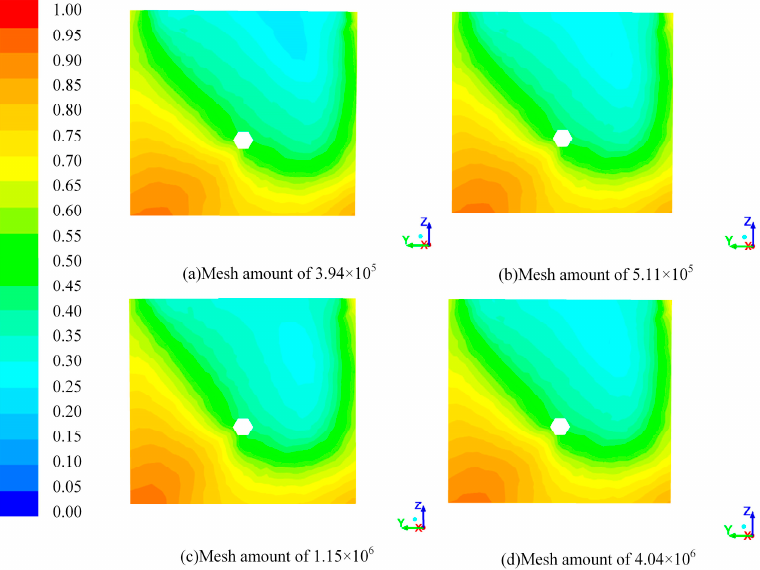
Figure 3. Methane concentration (%v/v) under different mesh generation. Energies 2019 , 12 , x FOR PEER REVIEW Table 1. Details for the mesh generation of computational domains.